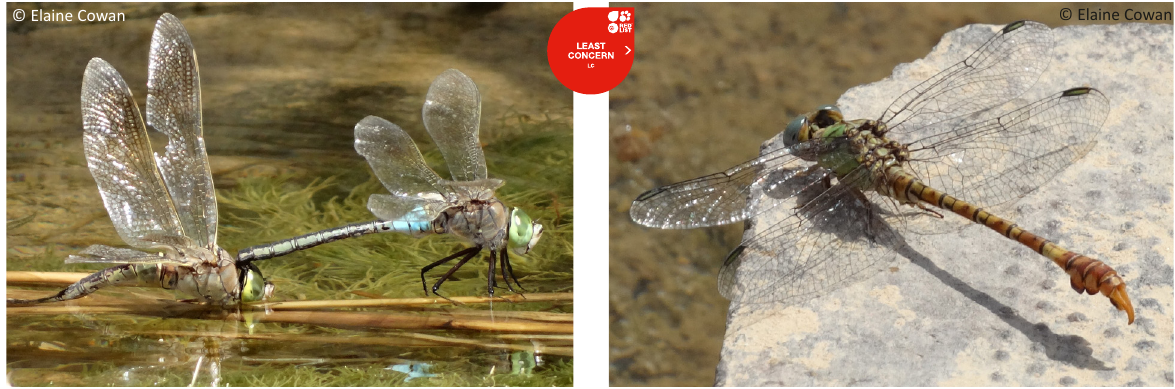
Image 10. Anax parthenope egg-laying in tandem, 10 March 2014. Male: green eyes, brown thorax, blue saddle around abdominal segments 2 and 3. Female: eyes above green with yellow below, brown thorax, yellowish band near base of abdomen.